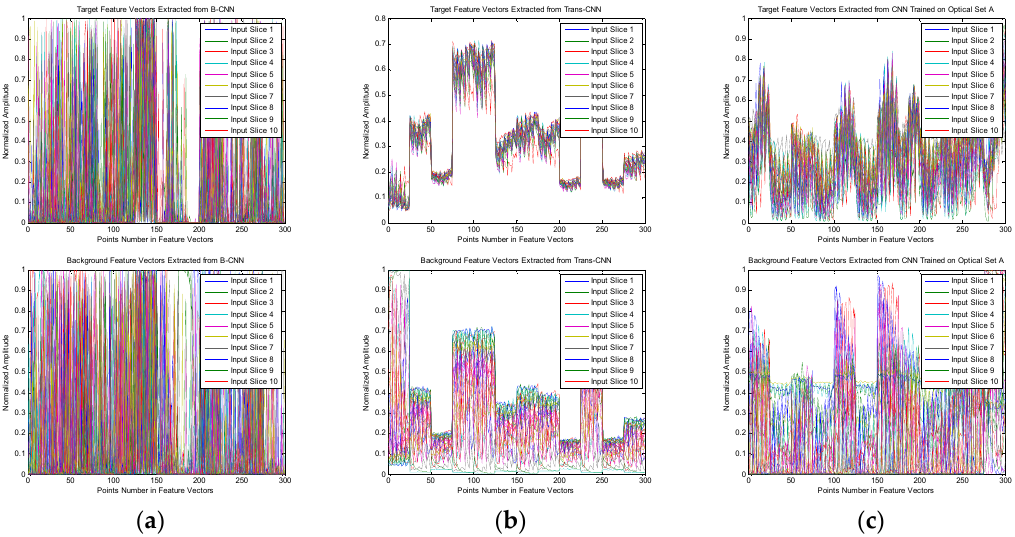
Figure 6. Feature vectors extracted from different networks. ( a ) Network A; ( b ) network B; (c) network